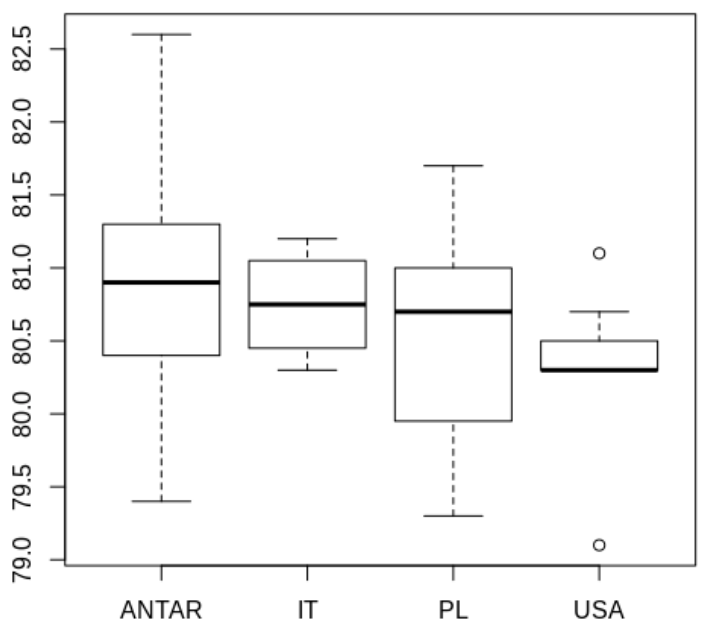
Figure 8. Differences in the pt of stylet supports insertion points ratio between the studied populations of Paramacrobiotus fairbanksi Schill, Förster, Dandekar and Wolf [25] (Antar, Antarctic; IT, Italy; PL, Poland; USA, USA). Minimum, maximum, median, first quartile, and third quartile for each population are presented.